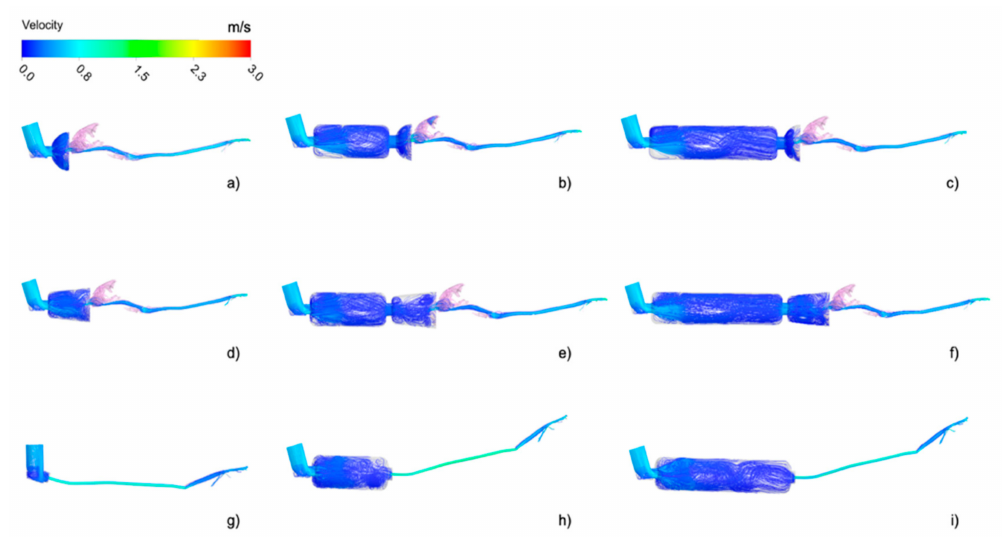
Figure 5. Peak inspiratory flow structure in the computed models depicted using streamlines and colored with the velocity intensity. ( a ) Spherical Mask, ( b ) Spherical Mask/Spacer 10 cm, ( c ) Spherical Mask/Spacer 20 cm, ( d ) Conical Mask, ( e ) Conical Mask/Spacer 10 cm, ( f ) Conical Mask/Spacer 20, ( g ) Endotracheal Tube (ETT), ( h ) ETT/Spacer 10 cm, ( i ) ETT/Spacer 20 cm. Red = high velocity; dark blue = low velocity.